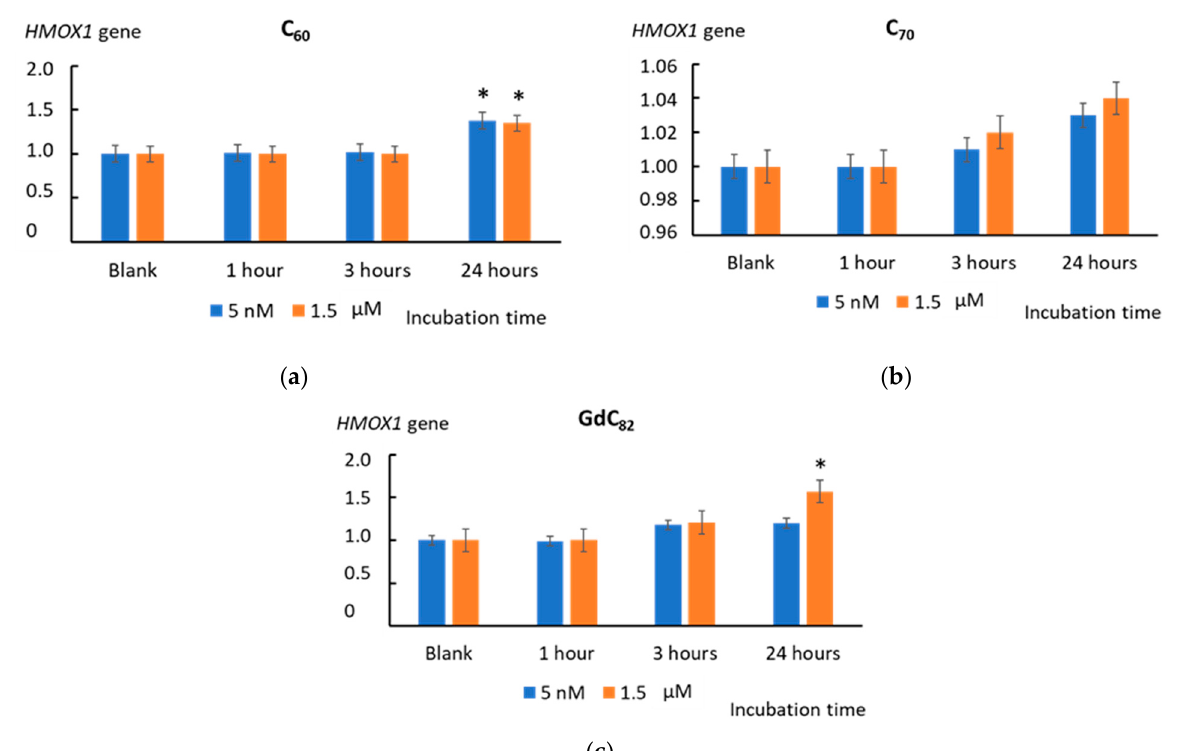
Figure 11. The expression of the HMOX1 gene in cells incubated with ( a ) C 60 , ( b ) C 70 , and ( c ) Gd@C 82 at concentrations of 5 nM and 1.5 µM. The HMOX1 RNA level is the mean from three replicates related to the HMOX1 gene expression in the blank cells. The TBP gene was used as an internal-standard gene. (*) denotes significant differences with the blank cells, p < 0.01, a nonparametric U-test.